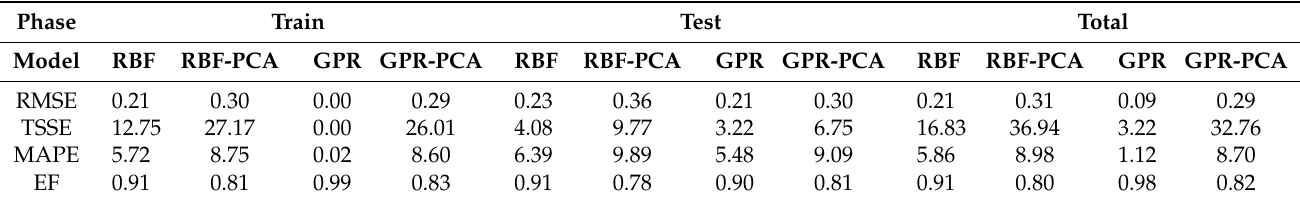
Table 9. RBF and GPR model performance with the optimal hidden layer neuron